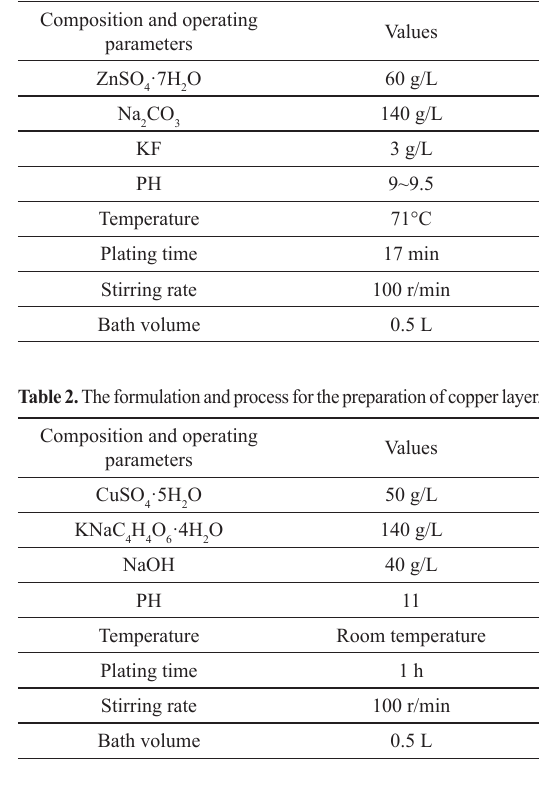
Table 3. Electroless bath composition and operating conditions of Ni-W-P